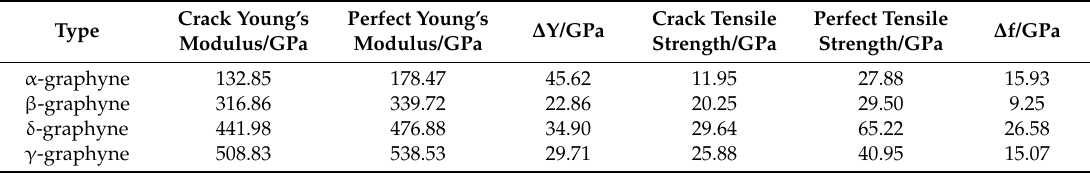
Table 1. Comparison of the Young’s modulus and tensile strength of four types of perfect graphyne and graphyne with a crack.